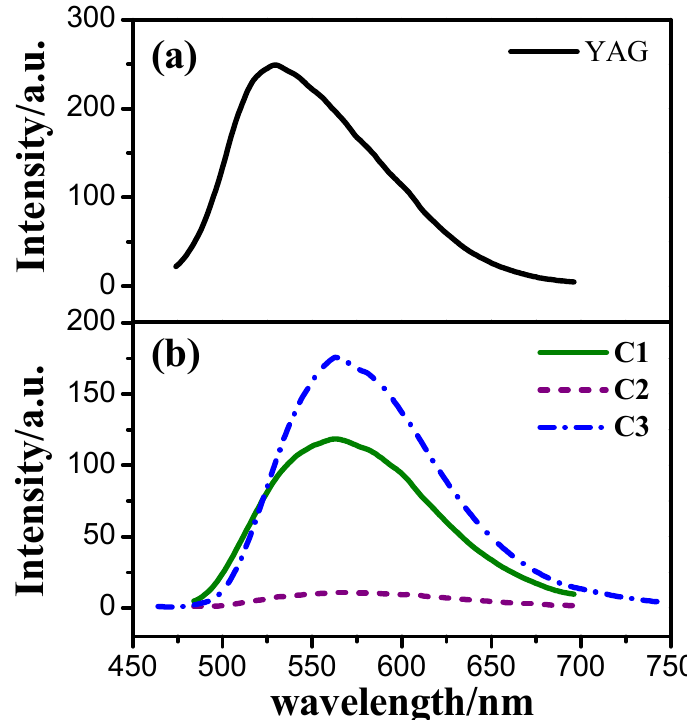
Figure 5. Emission spectra ( λ ex = 444 nm) of YAG ( a ) and the cationic iridium(III) complexes ( b ) powders.